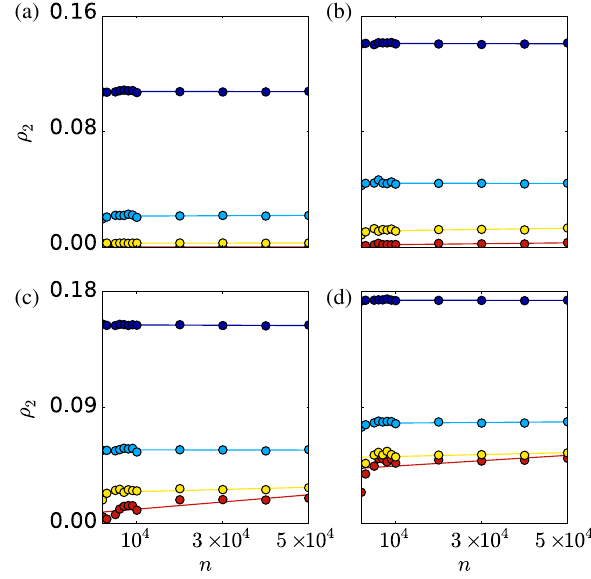
FIG. 13. The final fraction of infected nodes in the layer with the lowest individual eigenvalue as a function of the size of the layers. The colors represent different values of η . We show λ ¼ 0 . 078 in panel (a), λ ¼ 0 . 083 in panel (b), λ ¼ 0 . 085 in panel (c), and λ ¼ 0 . 088 in panel (d). Furthermore, the layer sizes are n ¼ 2 × 10 3 , 3 × 10 3 , 4 × 10 3 , 5 × 10 3 , 6 × 10 3 , 7 × 10 3 , 8 × 10 3 , 9 × 10 3 , 10 4 , 2 × 10 4 , 3 × 10 4 , 4 × 10 4 , and 5 × 10 4 , and m ¼ 2 in all cases. Each curve is the result of a parameter η ; from bottom to top, η ¼ 10 − 4 ; 10 − 3 ; 10 − 2 ; 10 − 1 .